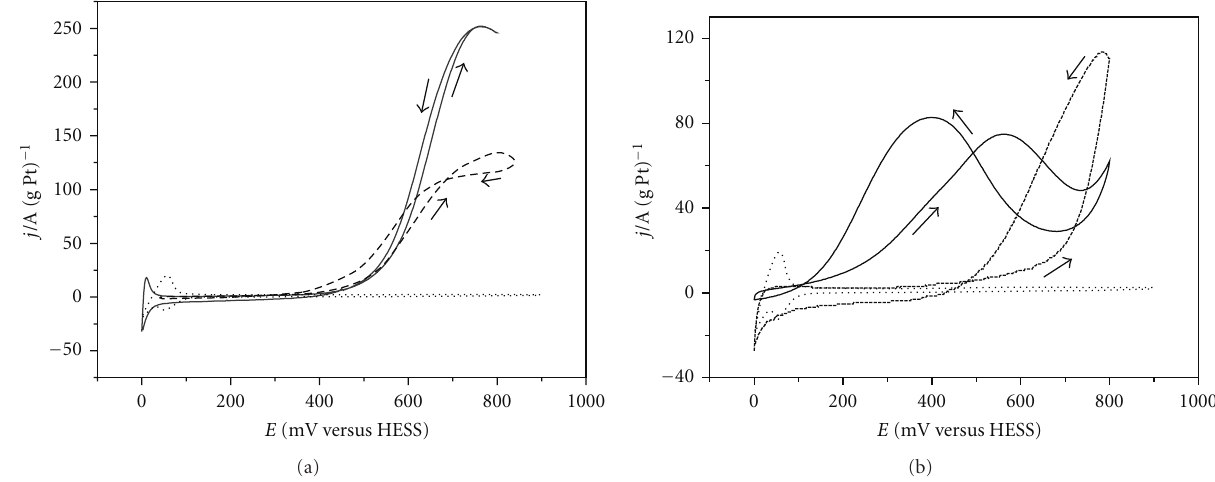
Figure 9: Voltammetric oxidation of 1.0M of methanol (a) and ethanol (b) in 0.5 M H 2 SO 4 on Pt-RuO 2 /C (full lines) and Pt/C (traced lines) composites fixed on BDD surfaces. Baselines (dotted lines) were included as a comparison. Scan rate ν = 10 mVs − 1 (reprinted with permission from